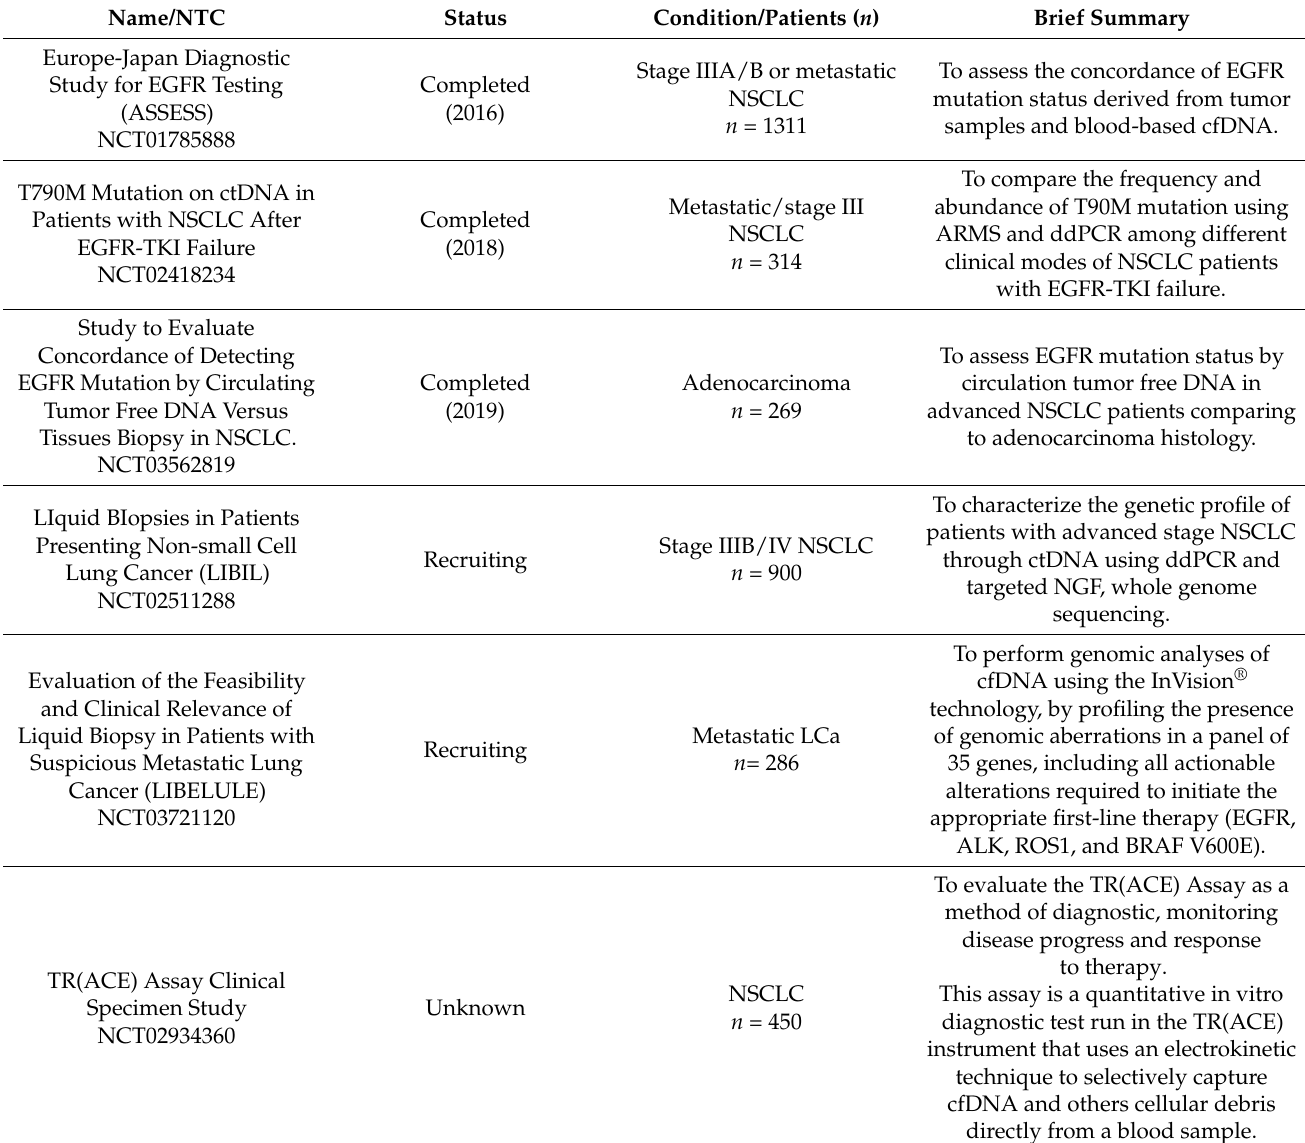
Table 2. Clinical trials regarding circulating cell-free DNA/circulating tumor DNA in lung